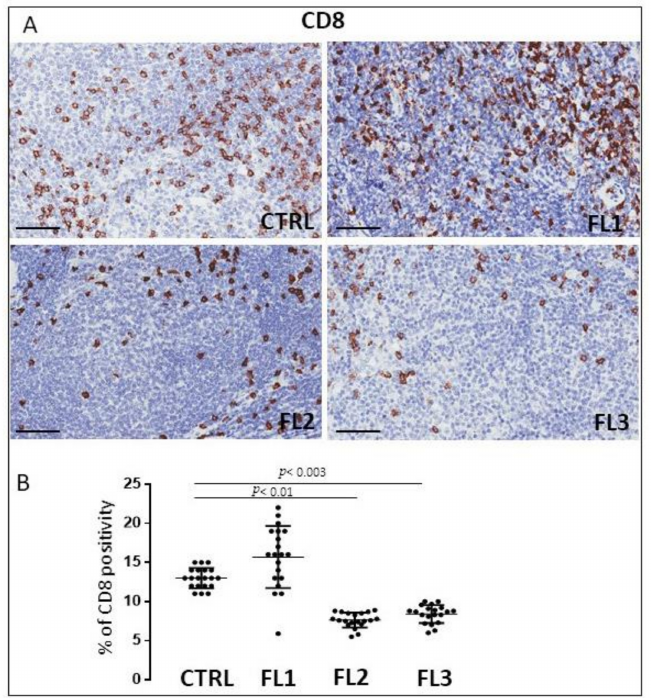
Figure 5. Immunohistochemical staining for CD8 in FL grade1 (FL1), FL grade2 (FL2), and FL grade 3 (FL3) and control samples (CTRL). Scale bar: 60 µ m ( A ). Morphometric analysis indicates the percentage of CD8 positivity in FL and CTRL samples ( B ).